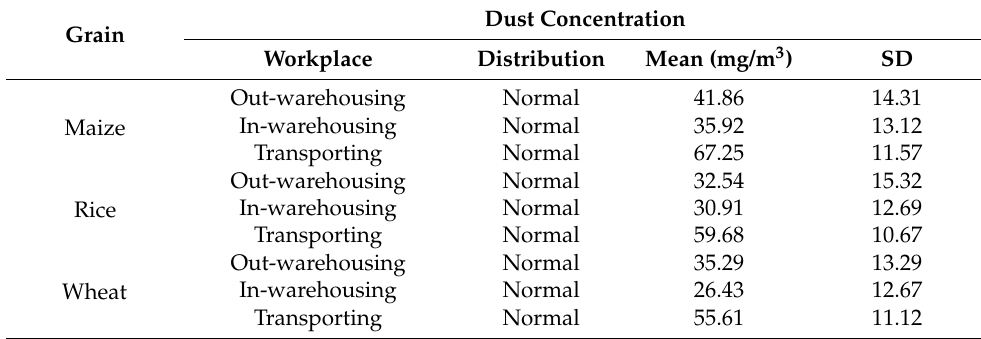
Table 4. Distribution characteristics of grain dust